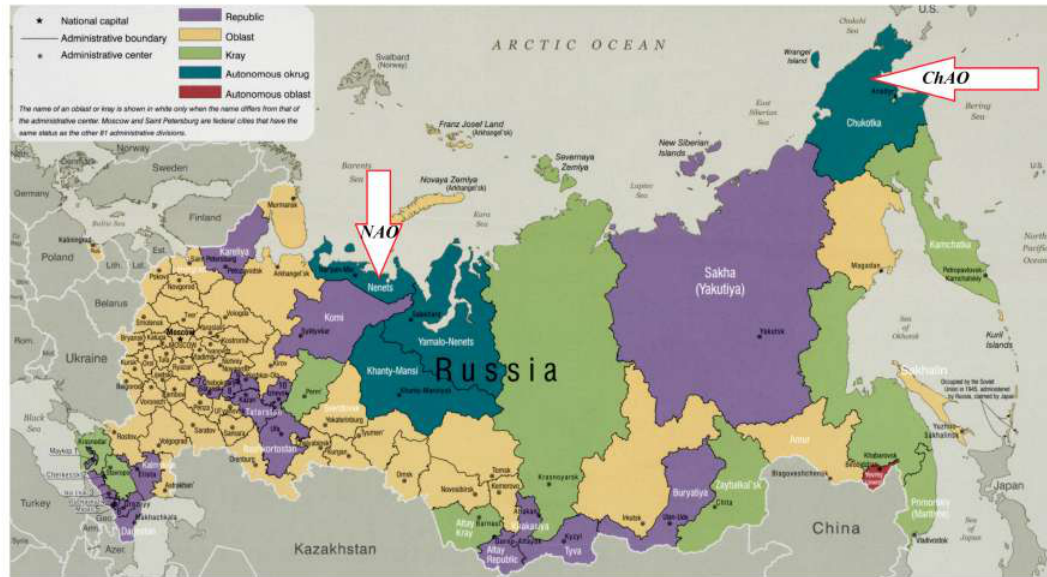
Figure 1. Political map of Russian Federation. (Available at: https://www.maps-of-the-world.ru/europe/russia/large-